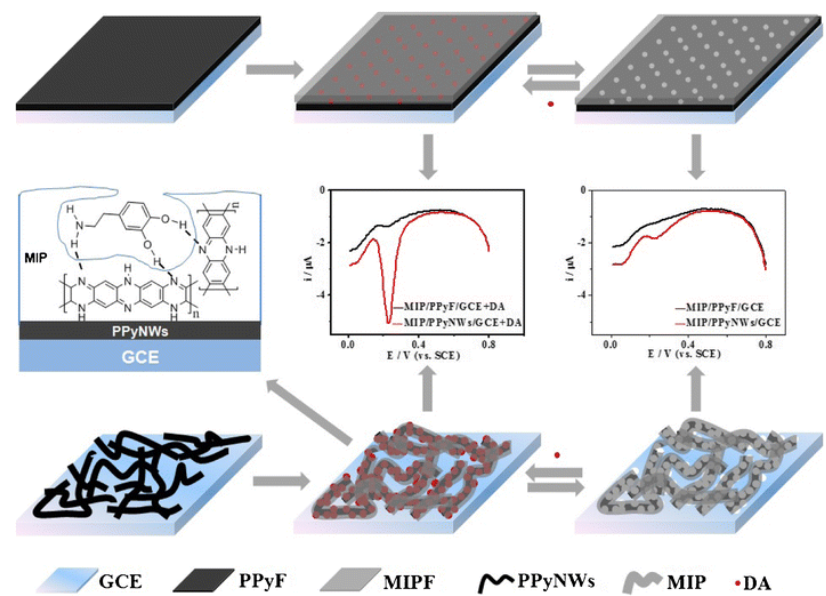
Figure 3. Schematic illustrations of the fabrication procedure of MIP/PPyNWs/GCE (Differential pulse voltammograms: Slight current of dopamine (DA)can be seen in left figure due to the extraction of DA; MIP/PPyNWs/GCE showed much higher current of DA than that of MIP/PPyF/GCE in middle figure owing to the excellent electrocatalysis of PPyNWs to DA. Reproduced by permission from Springer Nature, Microchimica Acta, Teng et al. [94], Copyright 2017.